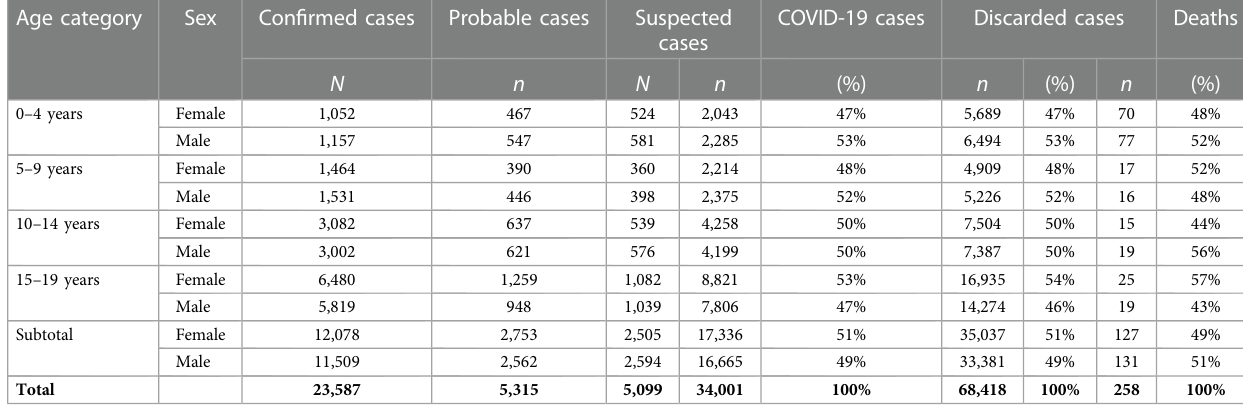
TABLE 1 Female and male COVID-19 cases reported among children and adolescents in Ecuador from 2020 to